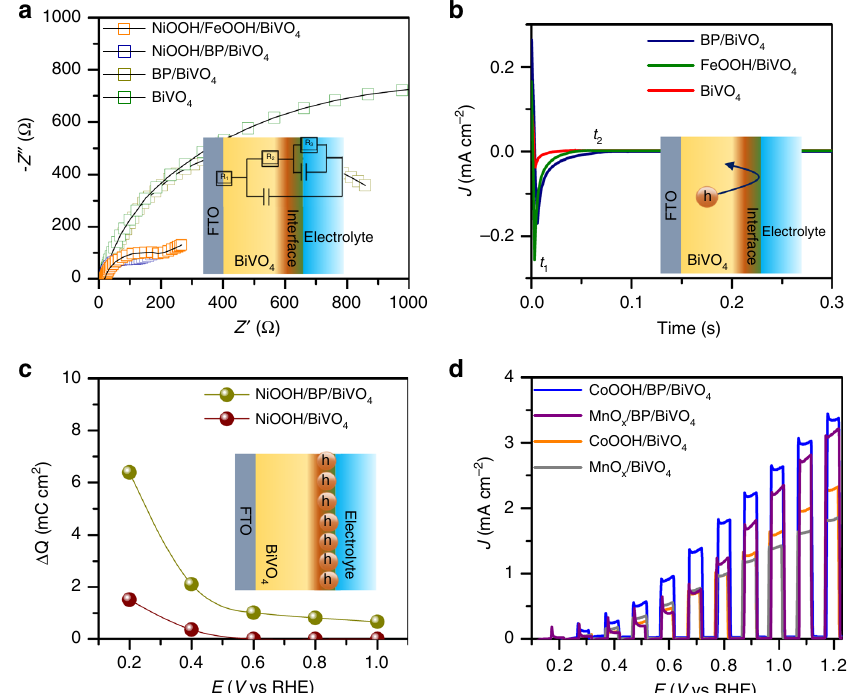
Fig. 4 PEC performance and electrochemical characterizations. a EIS Nyquist plots measured at 0.6 V vs RHE in KPi electrolyte (pH = 7.1) under AM 1.5 illumination, b Delay of the cathodic photocurrent curves measured at 0.2 V vs RHE in KPi electrolyte (pH = 7.1) under AM 1.5 illumination, c Charge storage capability against applied bias for both NiOOH/BiVO 4 and NiOOH/BP/BiVO 4 photoanodes. d Chopped J – V curves of CoOOH/BP/BiVO 4 and MnO x /BP/BiVO 4 photoanodes in KPi electrolyte (pH = 7.1) under AM 1.5 illumination